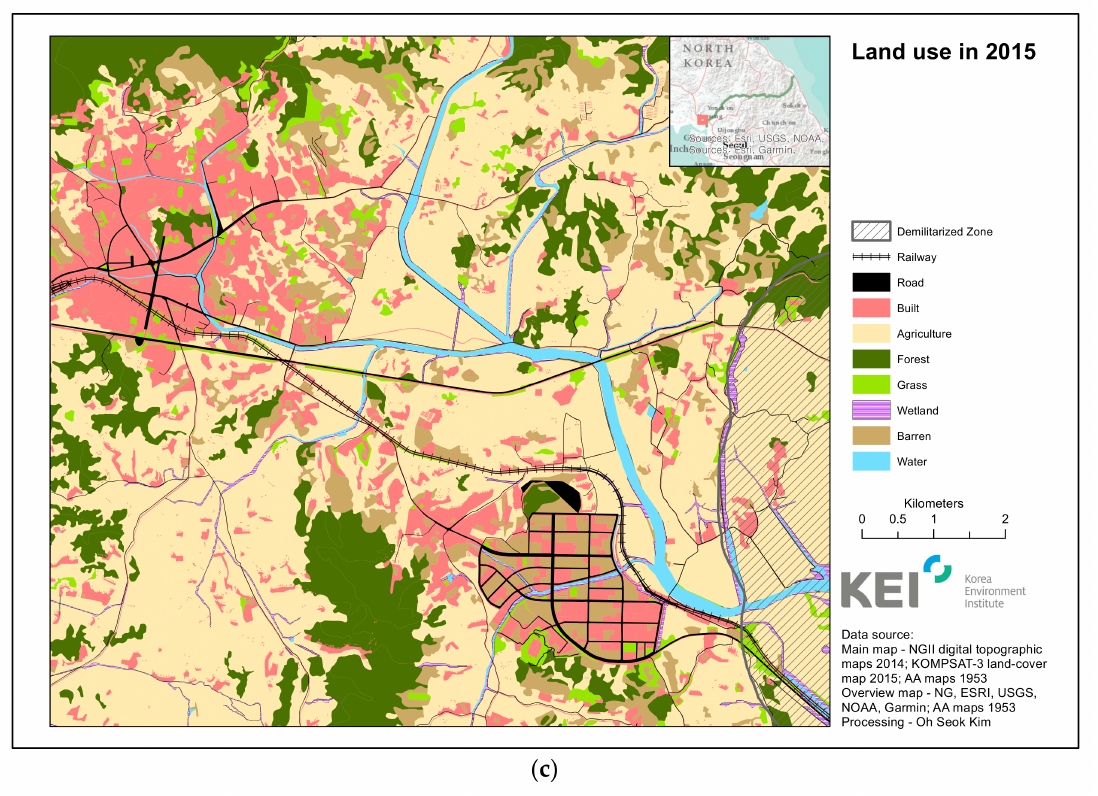
Figure 2. Land-cover maps in: ( a ) 1916 (p57), ( b ) 1951 (p59), and ( c ) 2015 (p61)